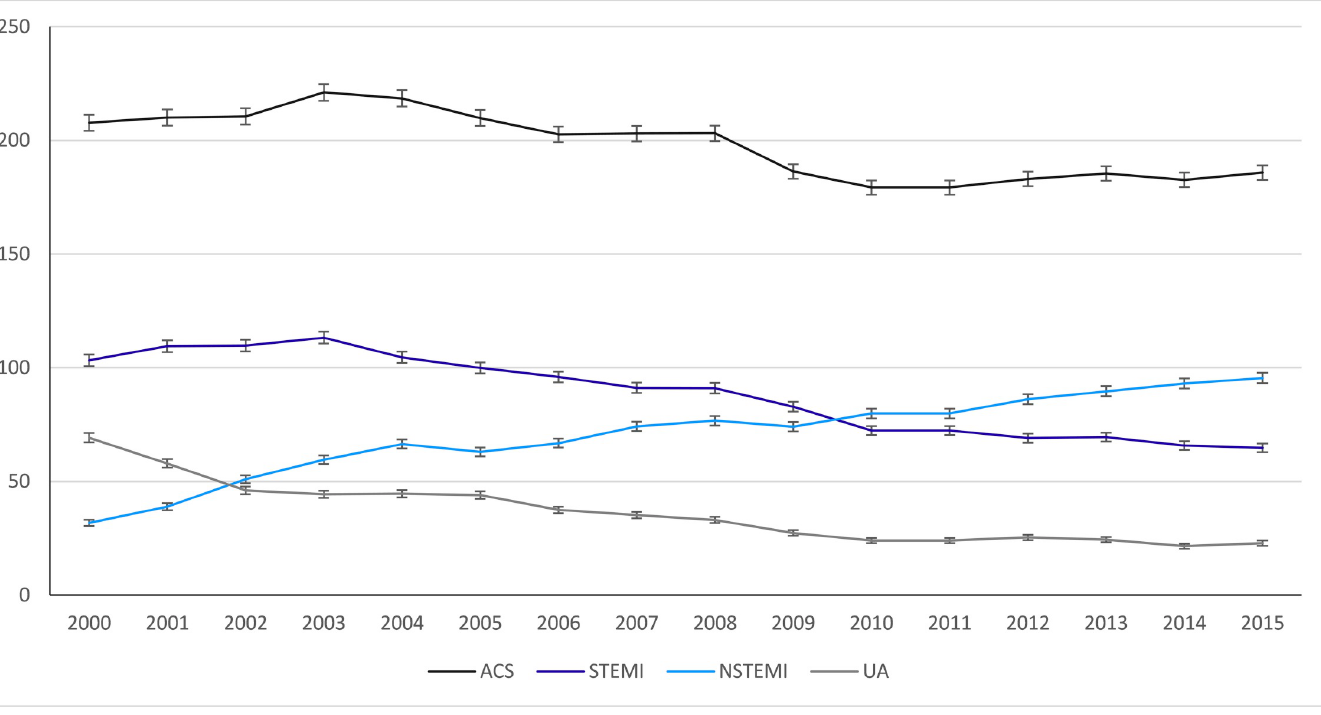
PLOS ONE | https://doi.org/10.1371/journal.pone.0255134 July 22,